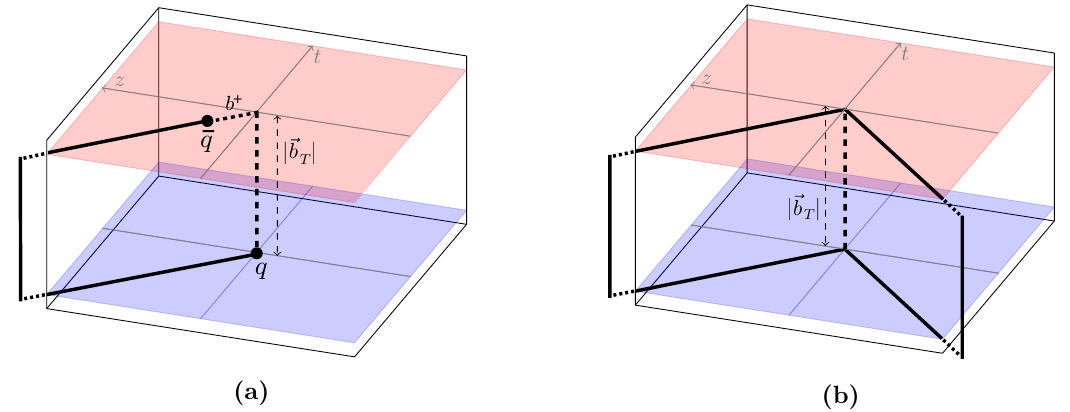
Figure 1. Illustration of the Wilson line structure of the n -collinear beam function B q (a) and the soft function S q (b), as given in eqs. (2.2) and (2.4). The solid Wilson lines extend to in(cid:12)nity in the directions indicated. Adapted from ref.